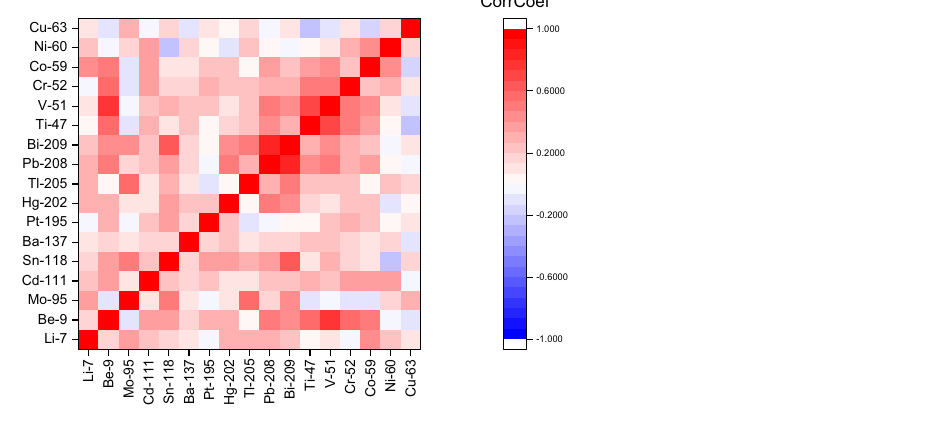
Figure 1. 2-D cross-correlation